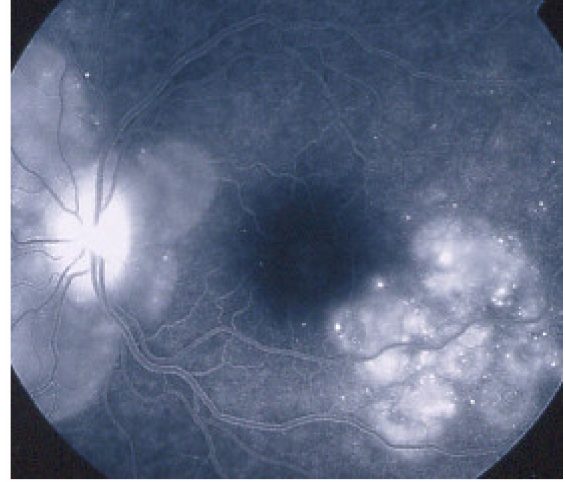
Figure 48. VKH exudative retinal detachments. FA showing posterior peripapillary and parafoveolar temporal inferior exudative retinal